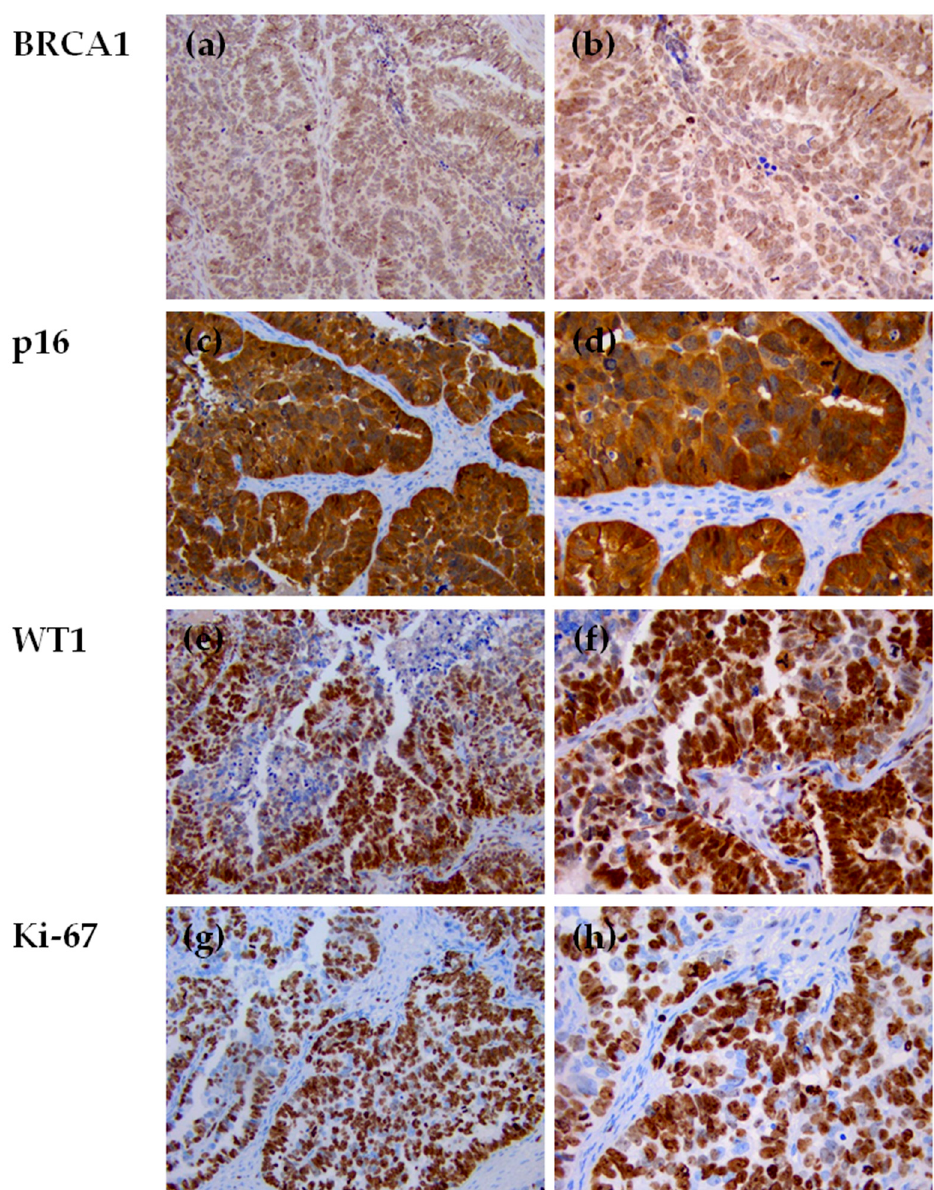
Figure 6. Immunohistochemical staining for BRCA1, p16, WT1, and Ki-67 of HGSOC sections collected at D-LPS from a patient diagnosed of HGSOC, before NACT (20× and 40× magnification). ( a , b ) Positive nuclear staining for BRCA1 observed in ~95% of tumor cells ( a : 20×, b : 40×); ( c , d ) Diffuse nuclear and cytoplasmic staining of p16 exhibited by ~95% of tumor cells ( c : 20×, d : 40×); ( e , f ) Nuclear and cytoplasmic staining for WT1 observed in ~70% of tumor cells ( e : 20×, f : 40×);( g , h ) Diffuse nuclear staining of Ki-67 observed in ~95% of tumor cells ( g : 20×, h : 40×). NACT: neo-adjuvant chemotherapy; HGSOC: high-grade serous ovarian cancer; D-LPS: diagnostic laparoscopy; BRCA1: BRCA1 DNA repair associated; WT1: Wilms tumor 1.